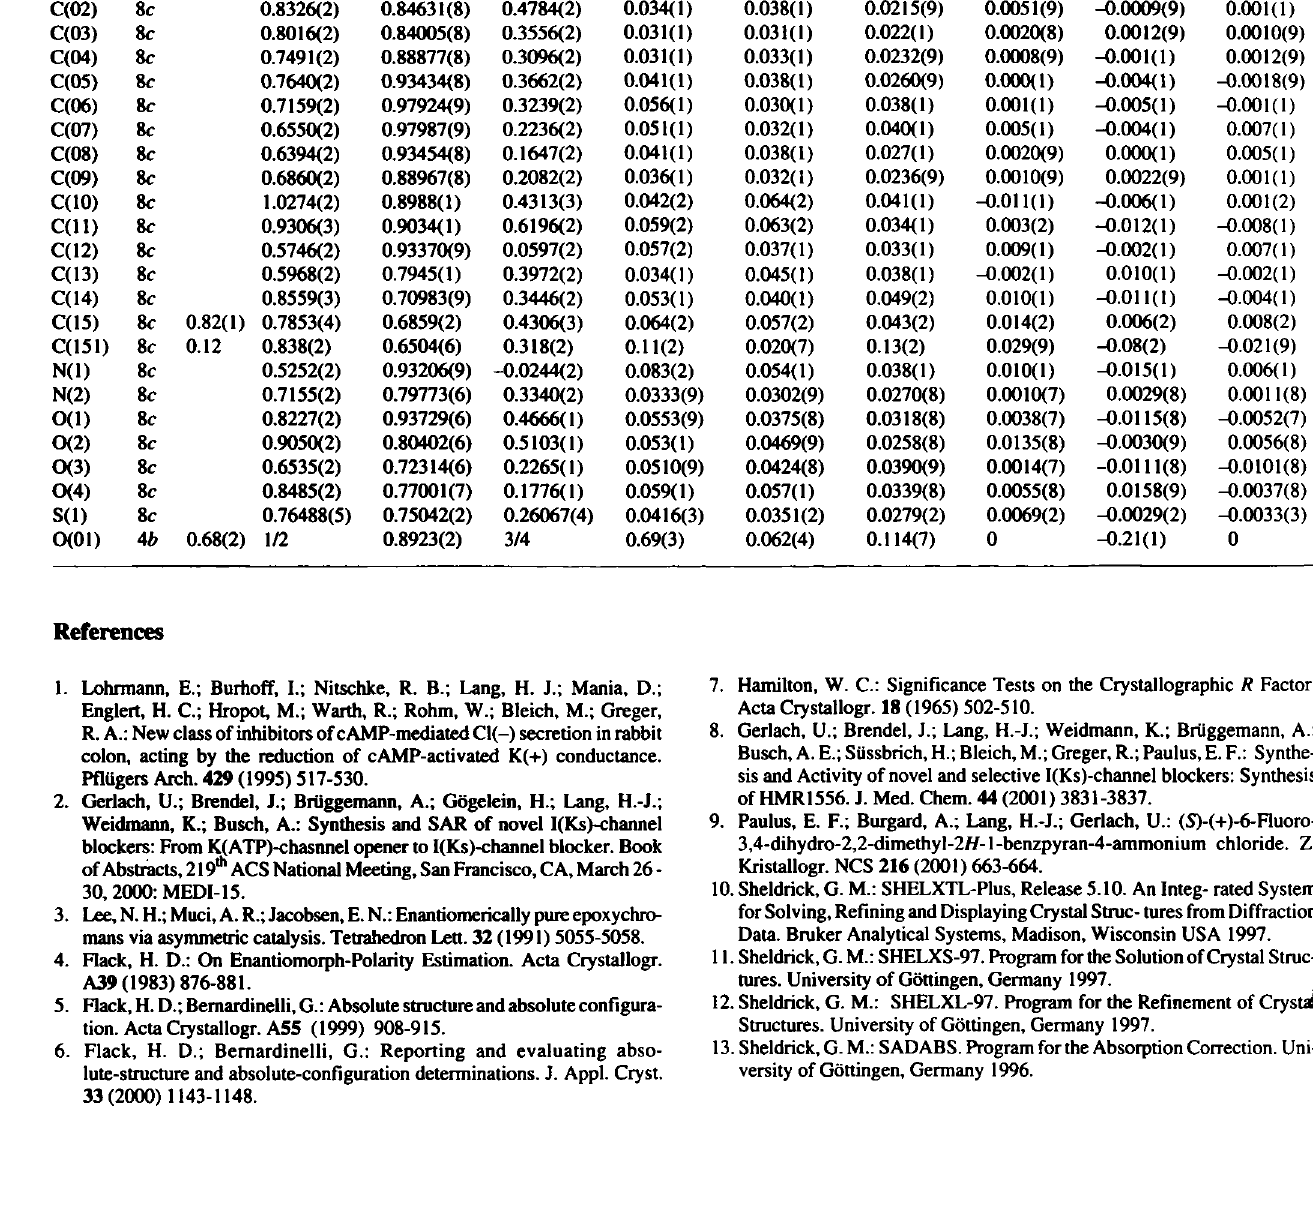
Table 3. Atomic coordinates and displacement parameters (in À 2